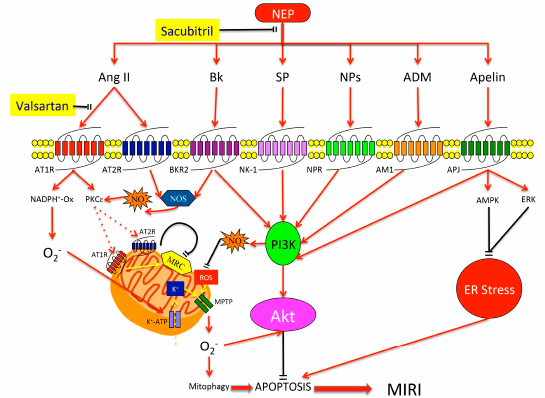
Figure 1. Molecular mechanisms of cardiomyocytes protection against MIRI and the potential effect of concomitant NEP inhibition/AT1R antagonism. NEP inhibition by sacubitril leads to increased levels of plasmatic Ang II, Bk, SP, NPs, ADM, and apelin. Increased Ang II levels, through a PKC ε dependent mechanism, lead to the AT1R and AT2R translocation from plasmatic to mitochondrial membrane where they exert their protective role. In particular, plasmatic AT1Rs stimulate NOS activity leading to superoxide generation, mitochondrial K + -ATP channel activity, membrane depolarization, and MPTPs opening. This process enhances the efflux of superoxide into the cytoplasm and promotes the activation of pro-survival kinases. By contrast, plasmatic AT2R stimulation leads to NOS-NO-PKG stimulation that further stimulates PKC ε . In the mitochondria, the up-regulation of AT2R / AT1R protein levels controls the MRC activity through a stimulatory mechanism composed of ROS and an inhibitory pathway involving NOS-NO. This latter exerts a master control on respiratory function as it modulates AT1Rs, while tonically suppressing electron transport chain activity. Concomitant inhibition of AT1R by valsartan blocks pro-apoptotic mechanisms mediated by this receptor, thereby, empowering pro-survival pathways induced by AT2R. Increased levels of Bk, SP, NPs, ADM, and apelin lead to PI3K-Akt and GSK-3 β protective pathways activation and suppression of pro-apoptotic mechanisms induced by ER stress. These cardioprotective actions are mediated by NO synthesis and by direct inhibition of caspase-3 cleavage. MIRI, myocardial ischemia-reperfusion injury; NEP, neprilysin; AT1R and AT2R, angiotensin receptor type 1 and 2; Ang II, angiotensin II; Bk, bradykinin; SP, substance P; NPs, natriuretic peptides; ADM, adrenomedullin; PKC ε , protein kinase C ε ; NOX, NAD(P)H oxidase; MPTPs, mitochondrial permeability transition pores; NOS, nitric oxide synthase; NO, nitric oxide; PKG, protein kinase G; PI3K, phosphatidyl-inositol-3 kinase; ROS, reactive oxygen species; MRC, mitochondrial respiratory chain; ER, endoplasmic